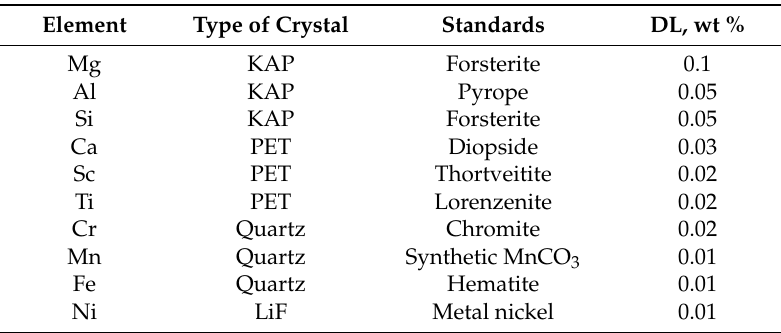
Table 2. Parameters of